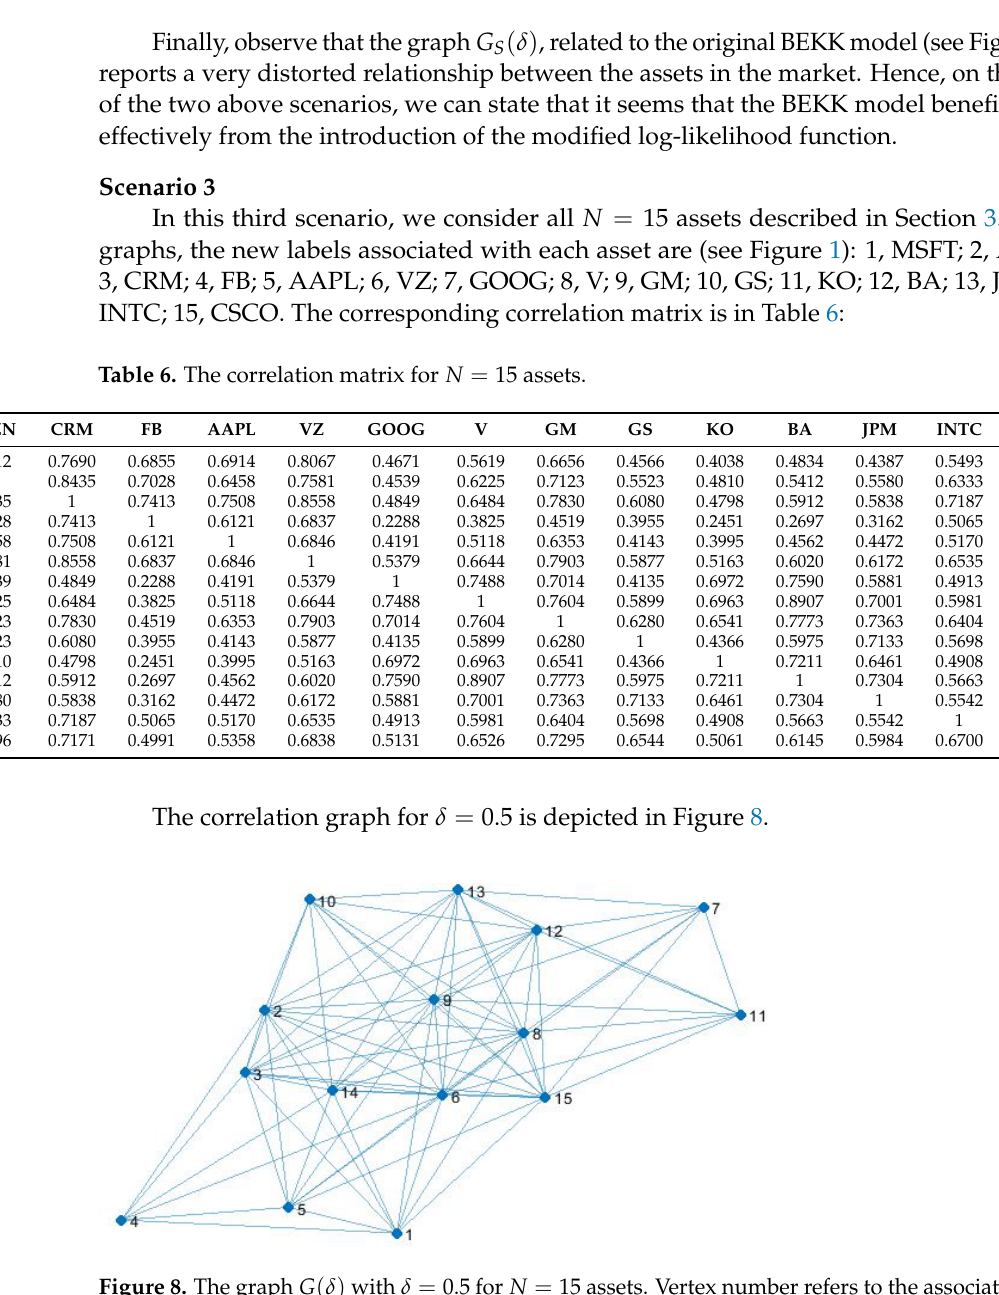
Figure 8. The graph G ( δ ) with δ = 0.5 for N = 15 assets. Vertex number refers to the associated asset. The maximal cliques in G ( δ ) with δ = 0.5 are: C 1 = { 1, 2, 3, 4, 5, 6, 14 } ; C 2 = { 1, 2, 3, 5, 6, 8, 9, 14, 15 } ; C = { 2, 3, 6, 8, 9, 10, 12, 13, 14, 15 } ; and C = { 6, 7, 8, 9, 11, 12, 13, 15 } 3 4